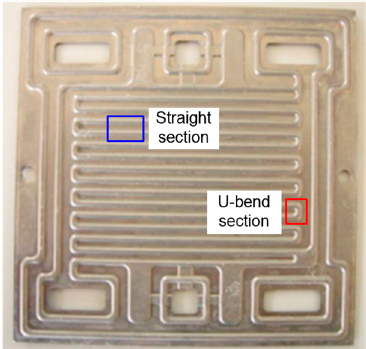
Figure 4. Example of a bipolar plate manufactured by forming, indicating both the straight and the U-bend channel sections: a BPP with an interdigitated flow field for reactant gases and a serpentine flow field for the coolant fluid on the opposite side [49].